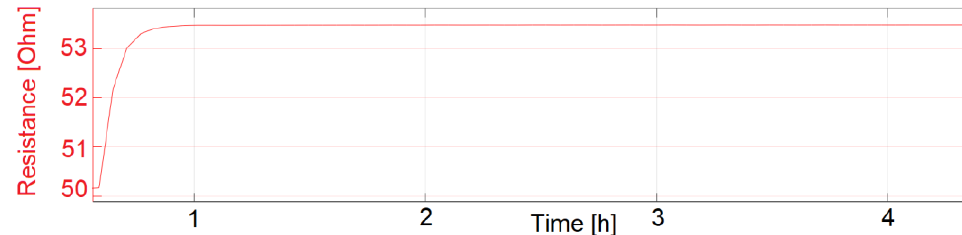
Figure 13. LCP 7 (with coating) start-up drift.